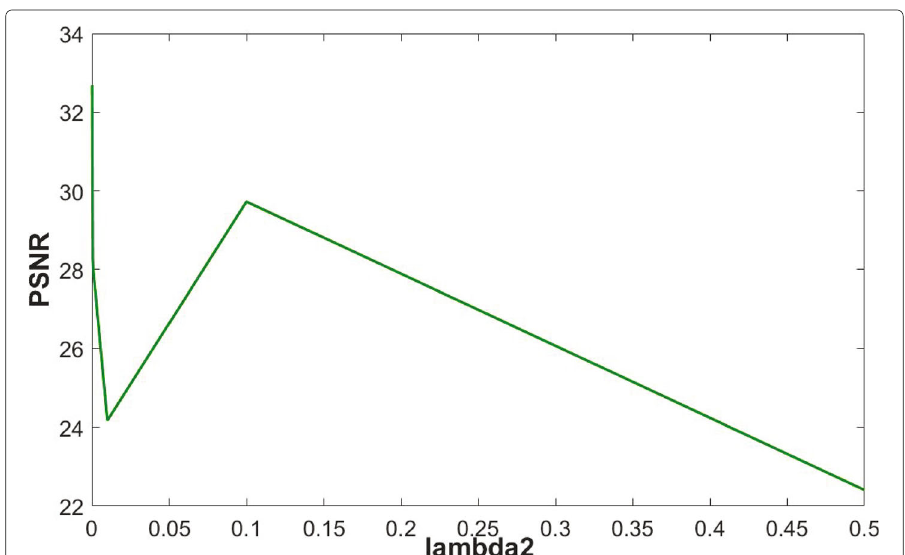
Fig. 8 PSNR of λ 2 in LRTV2++ in parameter